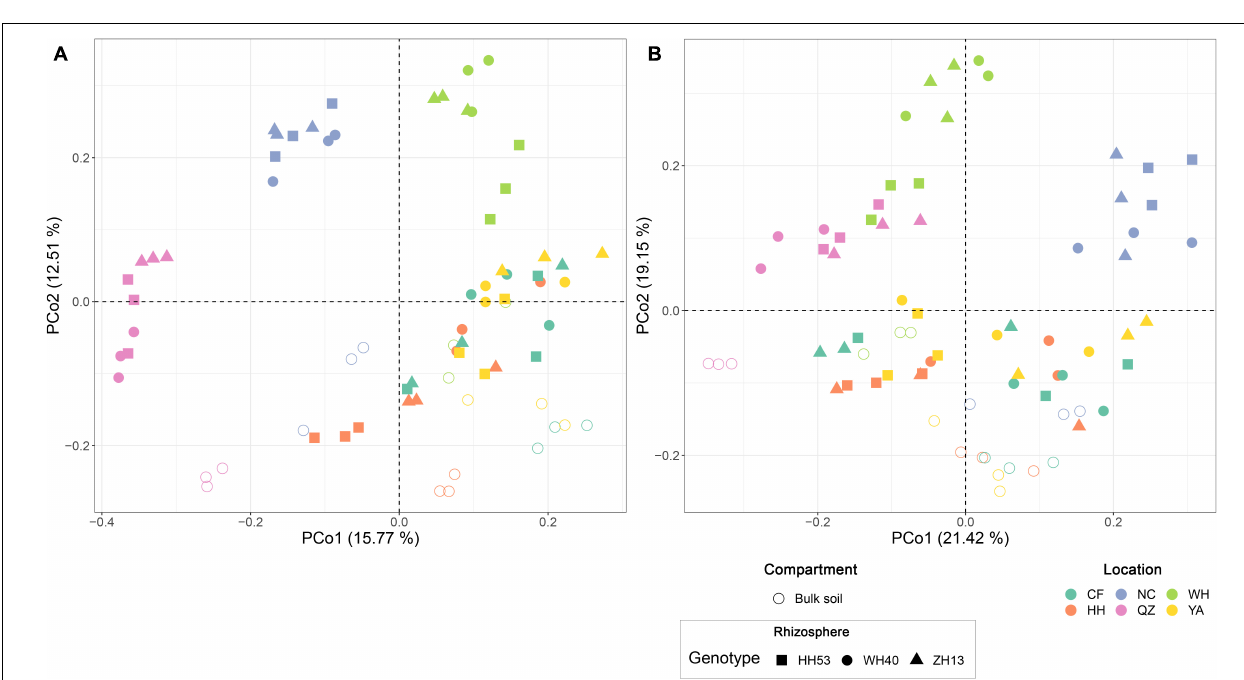
FIGURE 2 | Boxplots showing species richness (A) and phylogenetic diversity (B) of the bulk soil ( n = 18) and rhizosphere ( n = 54) compartments in soybean fields of China. Statistical differences were analyzed using Wilcoxon tests: *** P < 0.001.